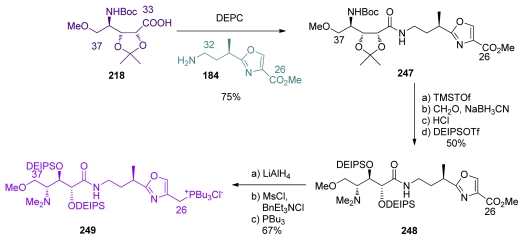
Preparation of C26–C37 fragment 249.